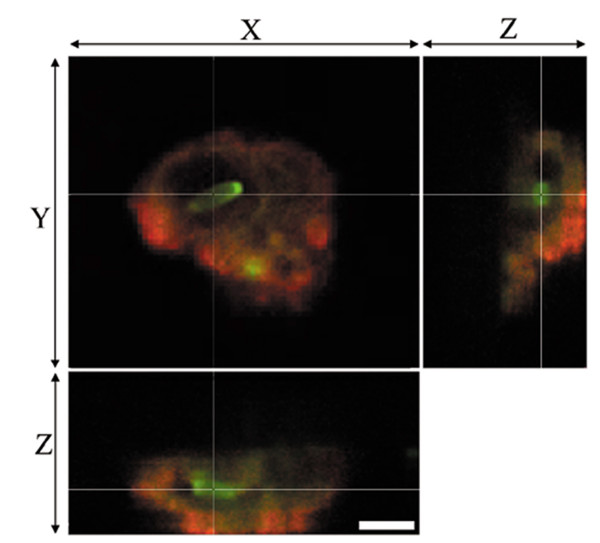
Intracellular E. coli within Campylobacter-treated enterocytes. Non-invasive E. coli HB101 (green) is localized in a membrane-bound vacuole (red) within C. jejuni-treated T84 enterocytes. Note confocal sectioning (i.e., x-z and y-z planes) showing cytoplasmic localization of the E. coli. Bar, 3 μM.